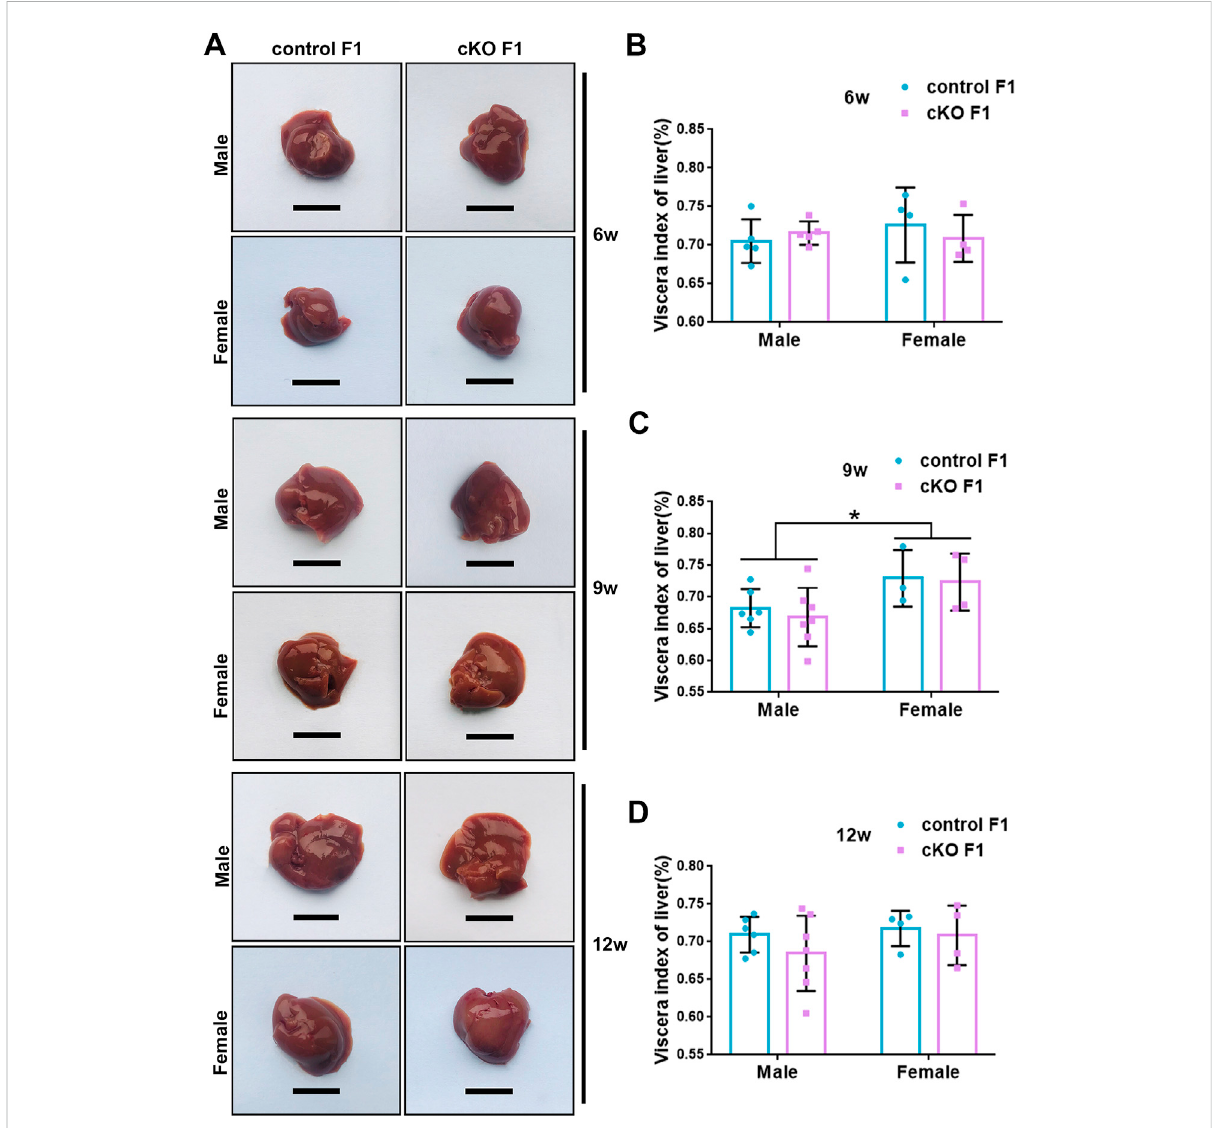
FIGURE 4 Liver morphology of the F1 generation of endometrial DNMT3B conditional knockout female mice (A) Liver morphology of control and cKO F1 male and female mice at 6-weeks, 9-weeks and 12-weeks of age. (B – D) Viscera index of liver was calculated in control and cKO F1 male and female mice at 6-weeks, 9-weeks and 12-weeks of age (n = 9 – 11). Results are presented as mean ± SEM. Scale bar: 1.5 cm * p <